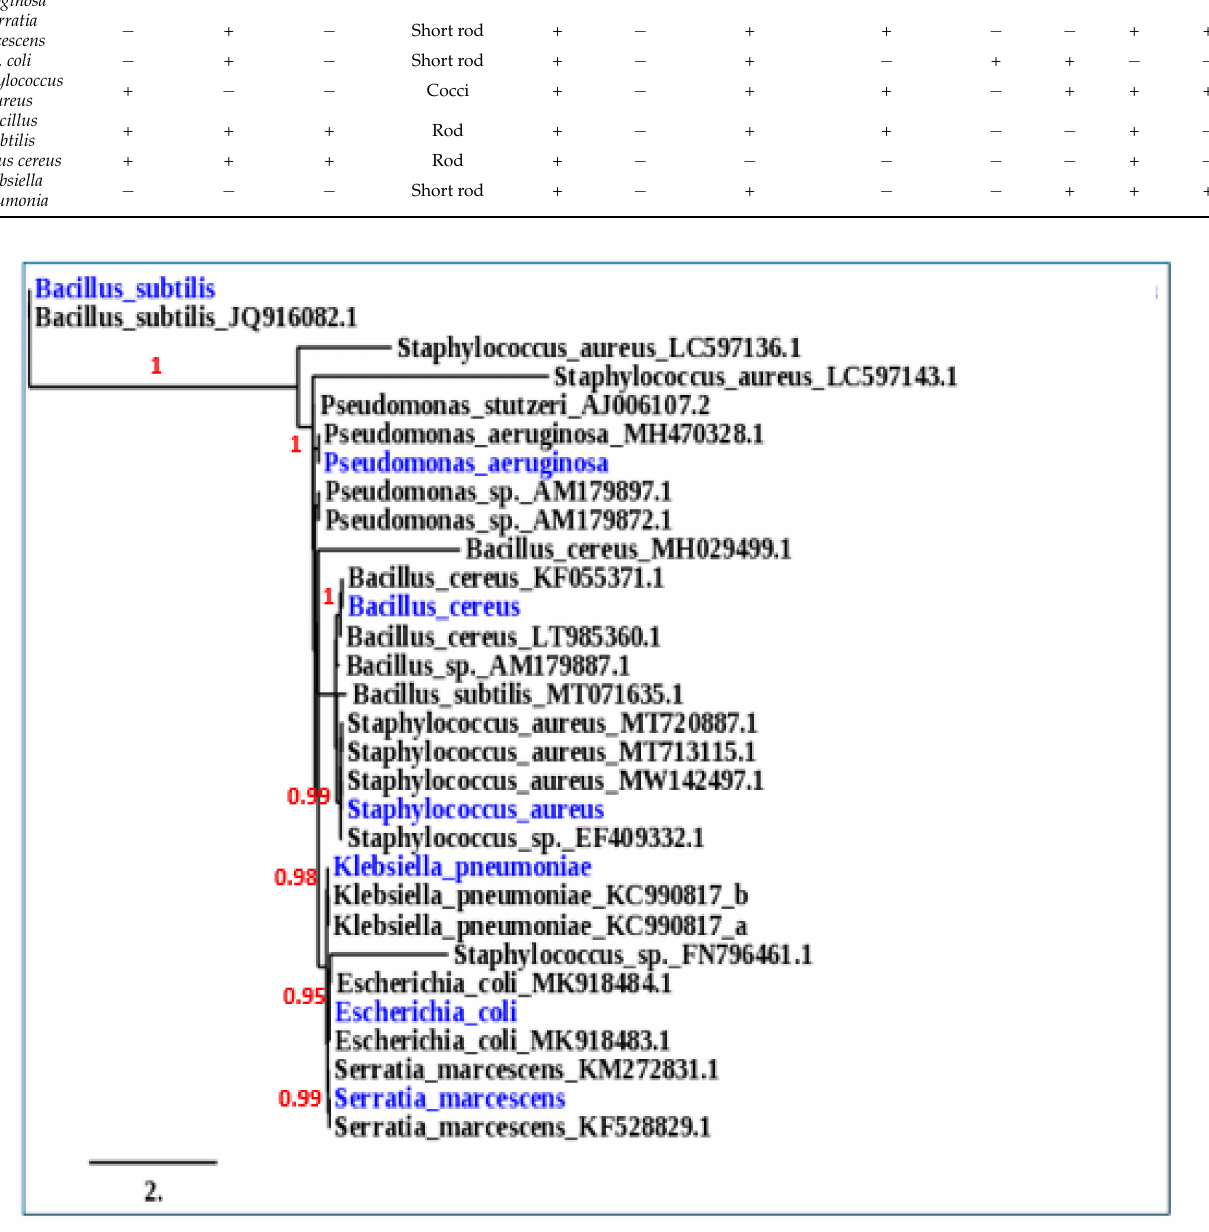
Figure 8. Phylogenetic trees of six bacterial isolates: E scherichia coli , Pseudomonas aeruginosa , Klebsiella pneumonia , Staphylococcus aureus , Serratia marcesnces , Bacillus cereus , and Bacillus subtilis